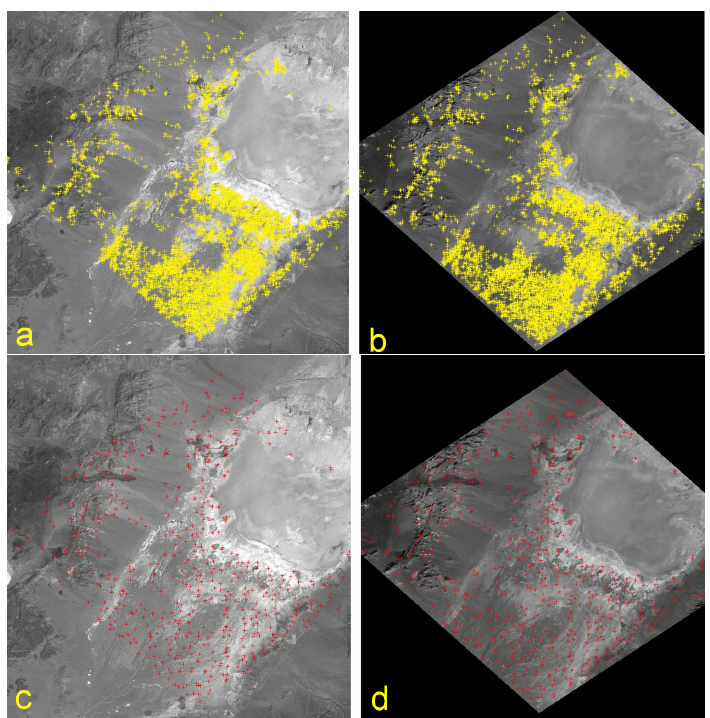
Figure 3. (First row) Homologous points (marked yellow) found by image matching. Left image ( a ): Reference (RI); Right image ( b ): coarsely orthorectified image by affine transformation (DESIS-PAN). (Second Row) Thinned out homologous points (marked red) between RI ( c ) and DESIS-PAN ( d ) based on best quality figure within a grid of 25 × 25 cells over the image. These points are used as GCPs to adjust the sensor model, whereas the remaining homologous points are used for quality assessment. Data: Railroad Valley, USA; 13 December 2018 18:23:11 UTC; 38.4467 ◦ N 115.7512 ◦ W; Sun Zenith 64.14 ◦ , Sun Azimuth 160.58 ◦ ; Incident Angle: 0.8 ◦